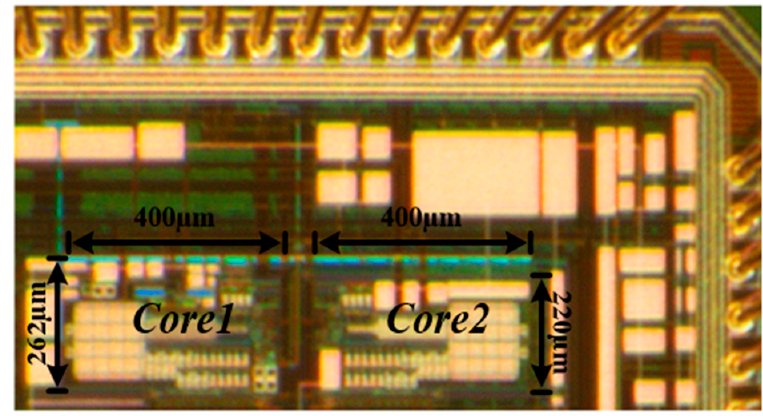
Figure 6. Die photo of two SAR ADCs where Core1 is the proposed design and Core2 is the conventional design. conventional